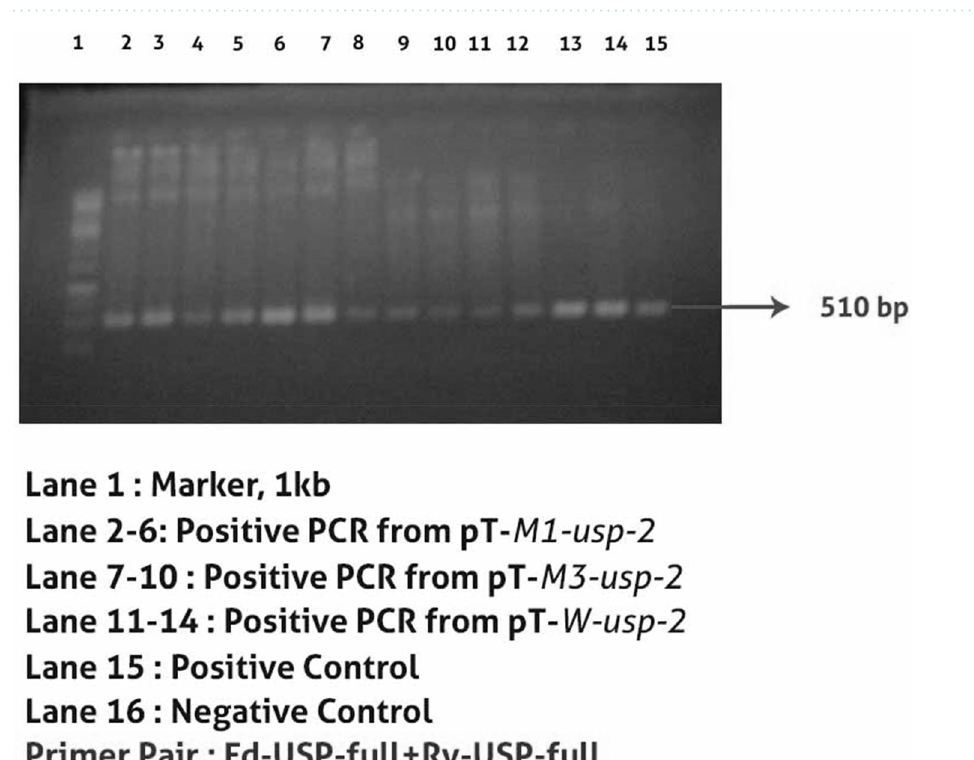
Figure 9. PCR amplification of W-usp-2 , M1-usp-2 & M3-usp-2 in transgenic